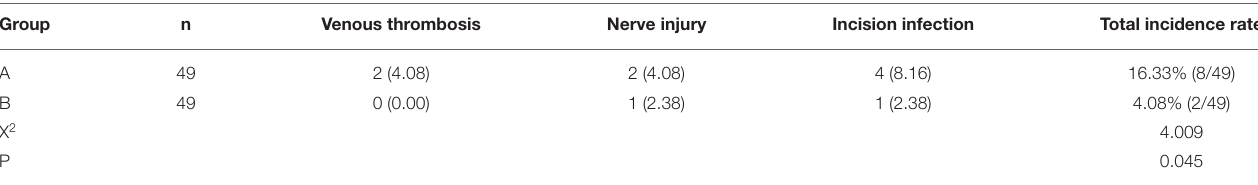
TABLE 4 | Postoperative complications